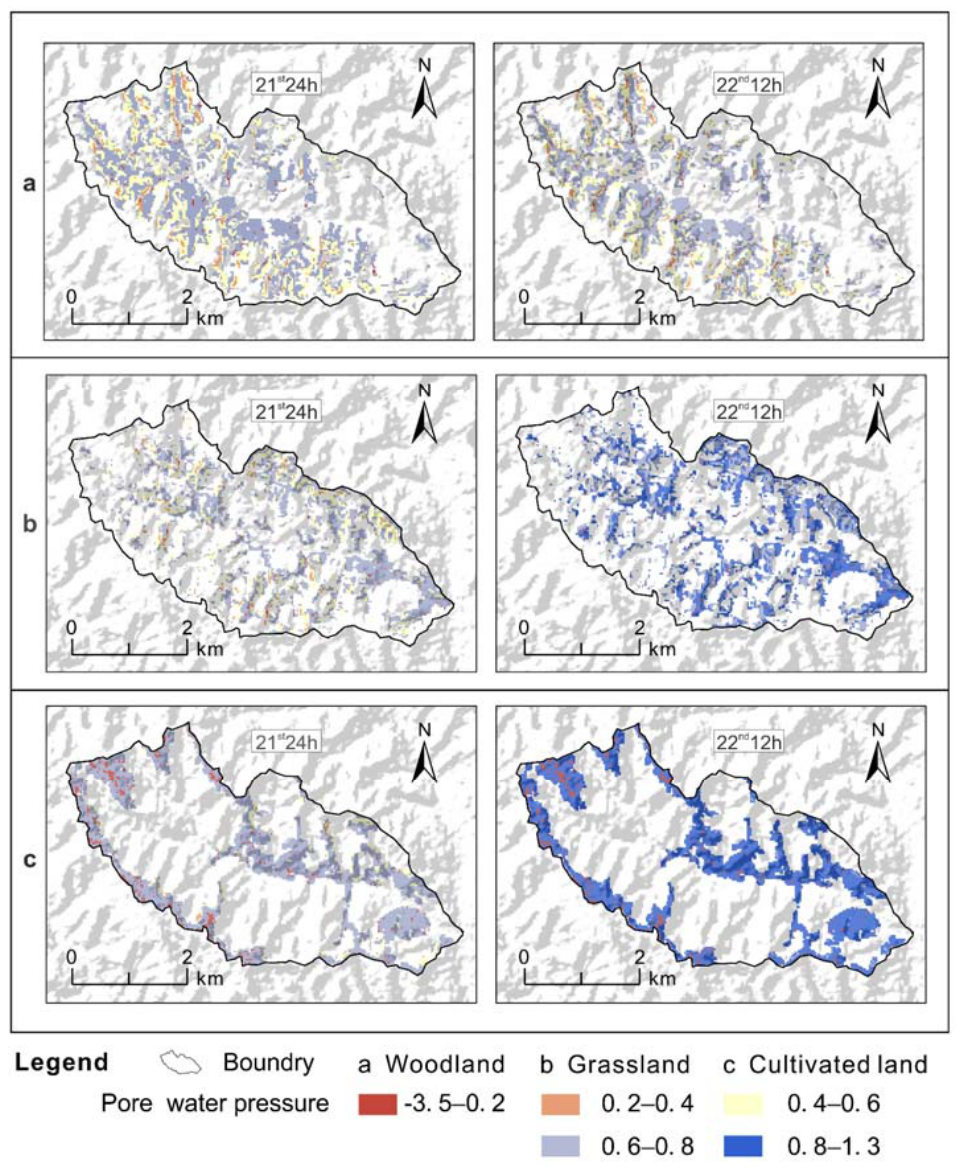
Figure 5. Spatial and temporal distribution characteristics of the pore water pressure for the different types of vegetation cover before and after the simulation (the grey base map represents the hillshade).